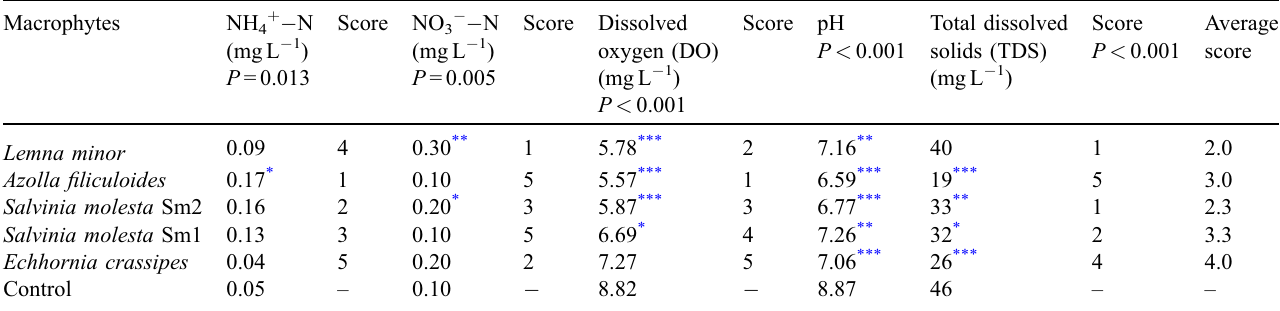
Table 3. Median values of water quality parameters differing signi fi cantly between fl oating macrophyte treatments ( n =15; Kruskal – Wallis ANOVA). Asterisks indicate signi fi cant differences compared with the control (without macrophytes): Dunn's methods. pH was not scored due to its high variability in the control (see